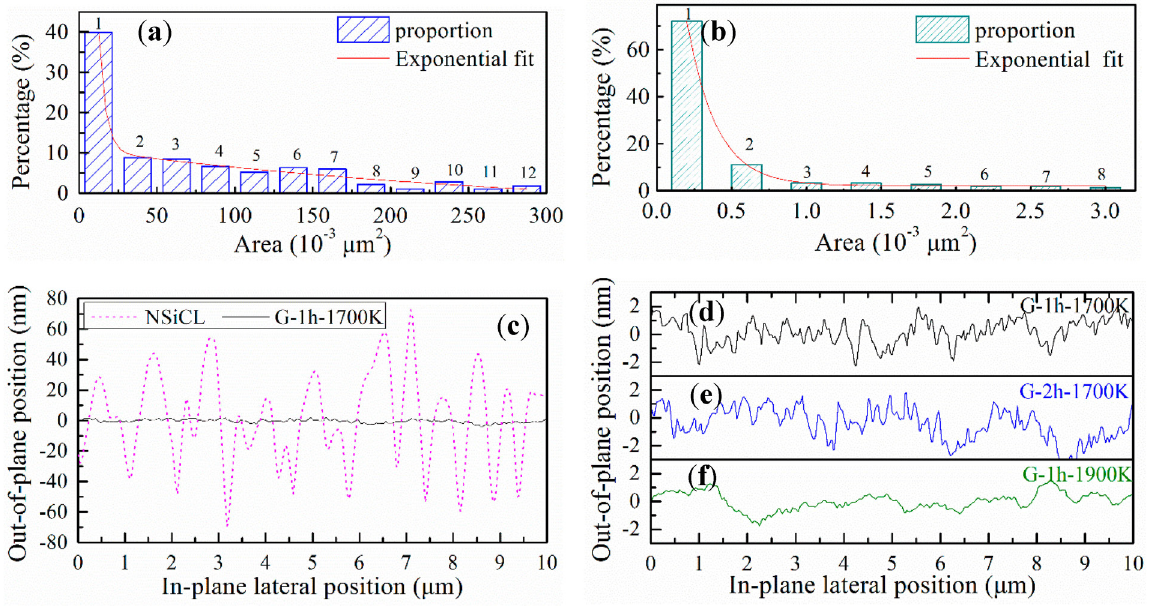
Figure 2. Statistical histograms of ( a ) NSiCL and ( b ) graphene G-2h-1700K, and line-sectional analyses of ( c ) NSiCL and graphene G-1h-1700K, ( d ) G-1h-1700K, ( e ) G-2h-1700K and ( f )